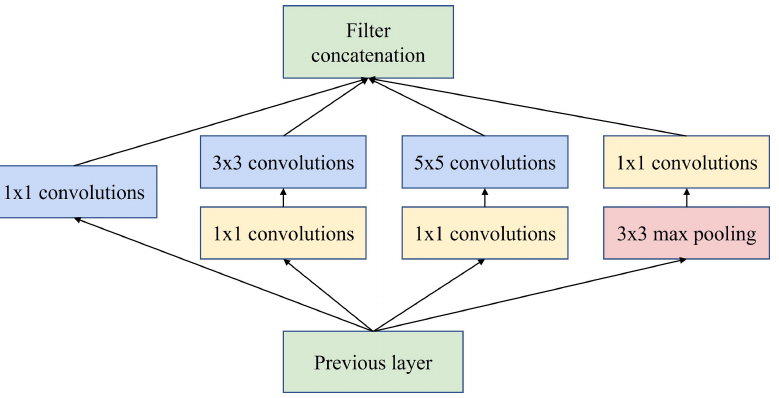
Figure 4. Inception module with dimensionality reduction from the GoogLeNet